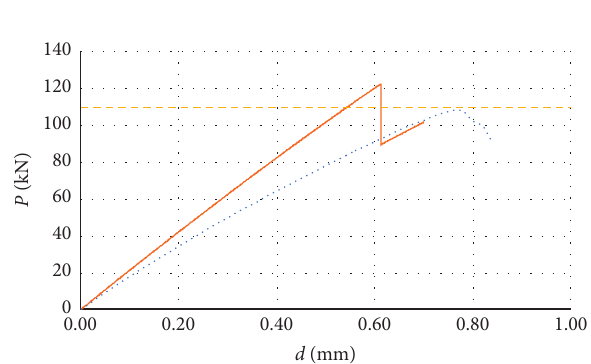
Figure 8. Brick and mortar linear and nonlinear mechanical